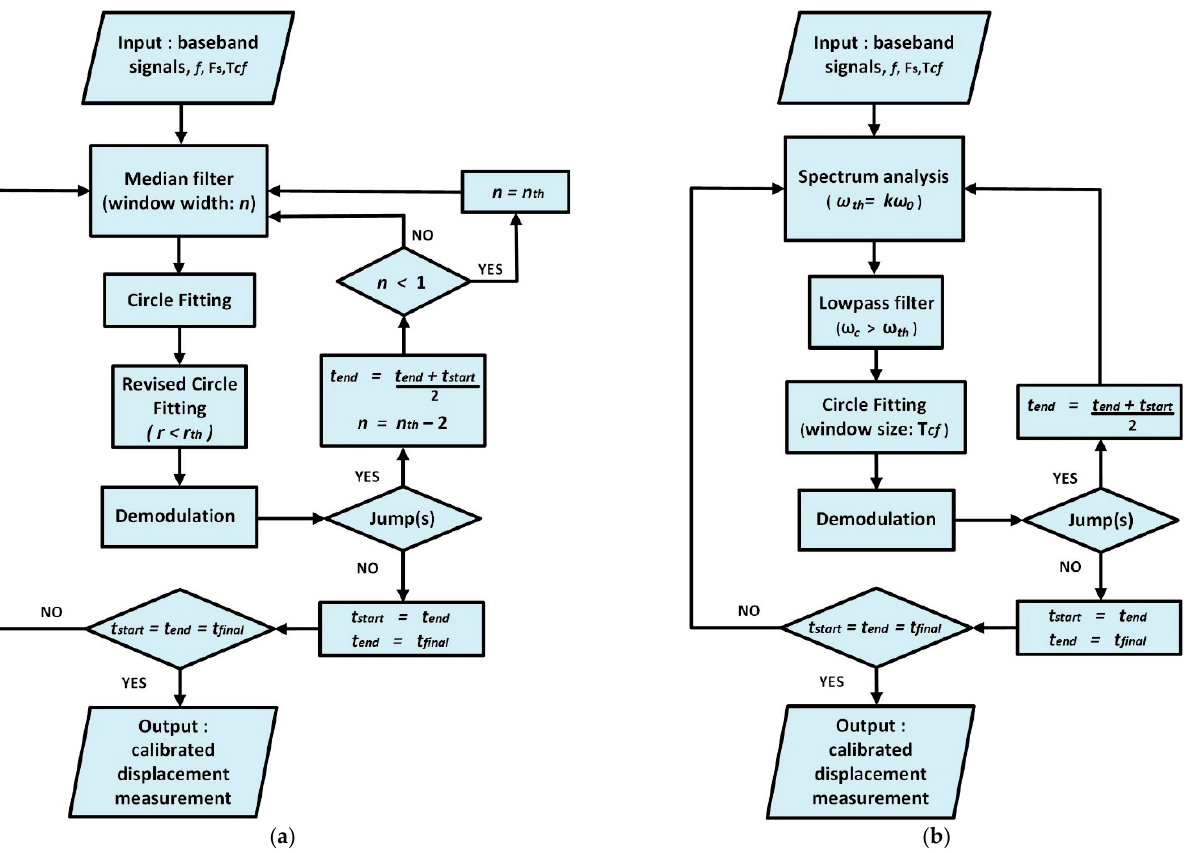
Figure 7. Flowchart for the propose adaptive displacement calibration strategies: ( a ) adaptive joint signal processing algorithm; ( b ) adaptive lowpass filtering algorithm. Reprinted with permission from ref. [71]. Copyright 2020 IEEE.